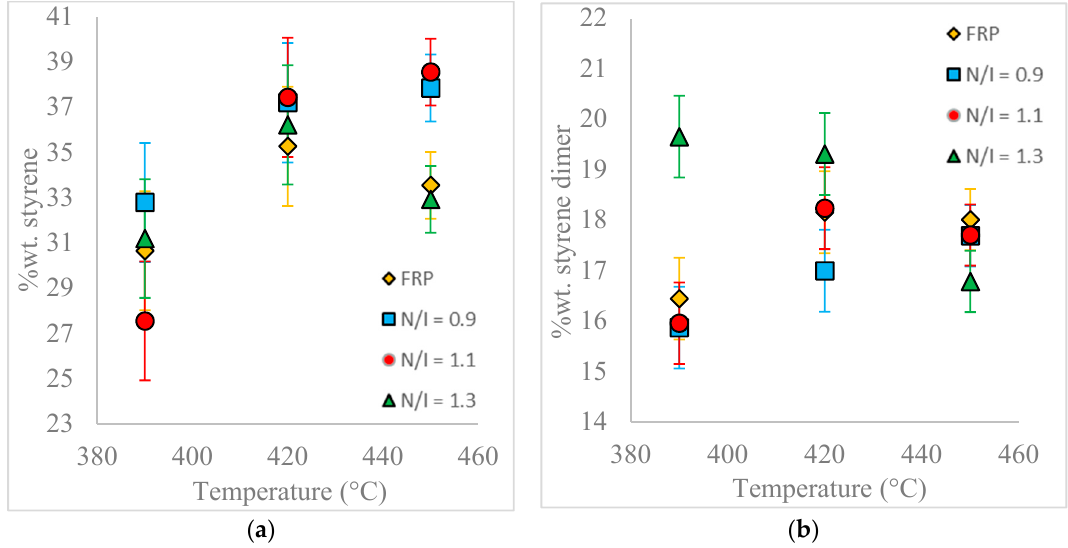
Figure 5. Absolute yields of ( a ) styrene and ( b ) styrene dimer of the analyzed samples.